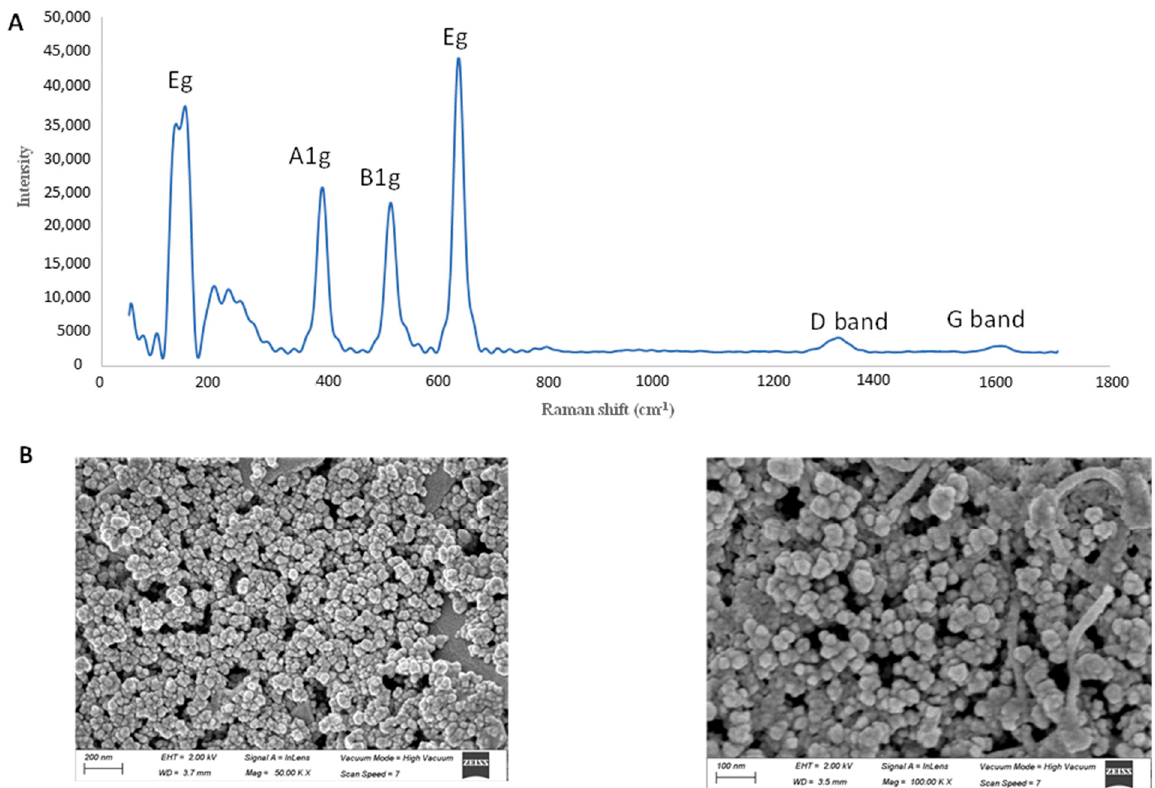
Figure 1. Characterization of TiO 2 -MWCNTs-MIP by Raman spectrum ( A ), and SEM images ( B ), images are presented at magnification of 50KX and 100KX.